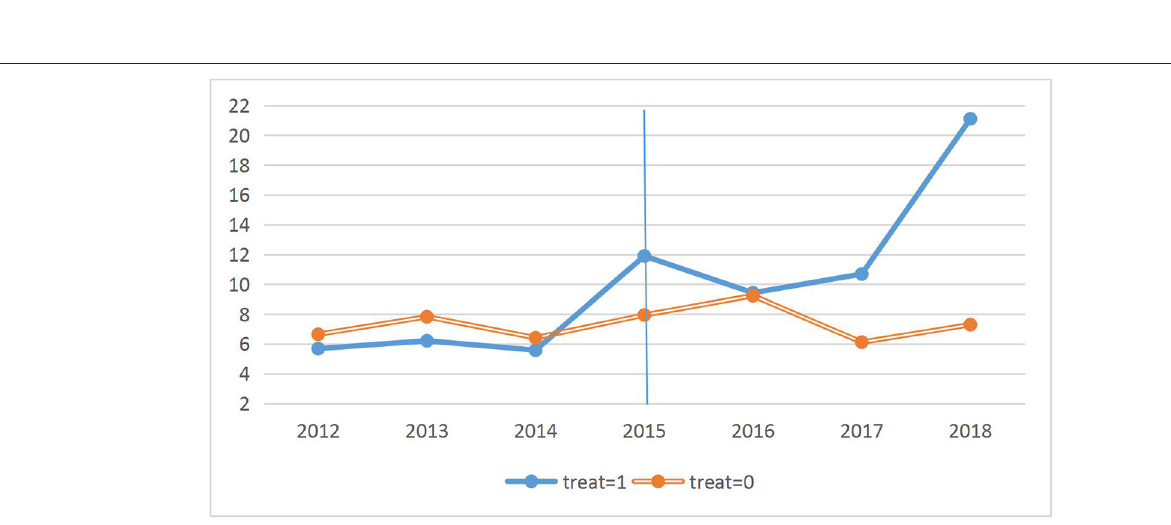
Frontiers in Energy Research |